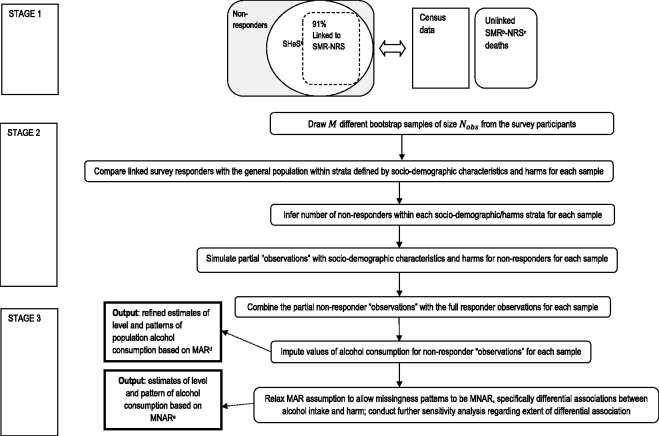
Summary of methodological strategy for addressing survey
non-representativeness and refining alcohol consumption estimates.
aSHeS: Scottish Health Survey; bSMR: Scottish
Morbidity Record; cNRS: National Records of Scotland;
dMAR: missing at random; eMNAR: missing not at
random.